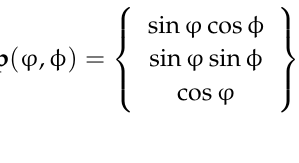
Figure 6. Coordinates of the vector (cid:1816)(φ, ϕ) defining by the angles φ and ϕ .